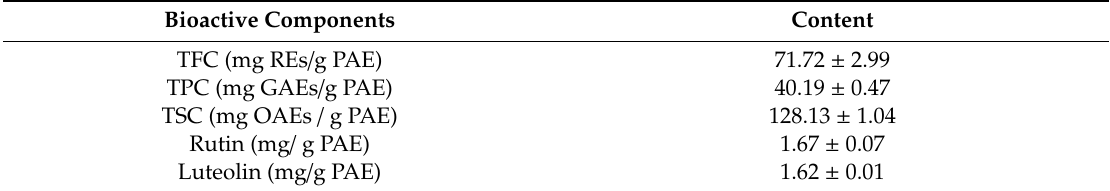
Table 1. The bioactive components of PAE.